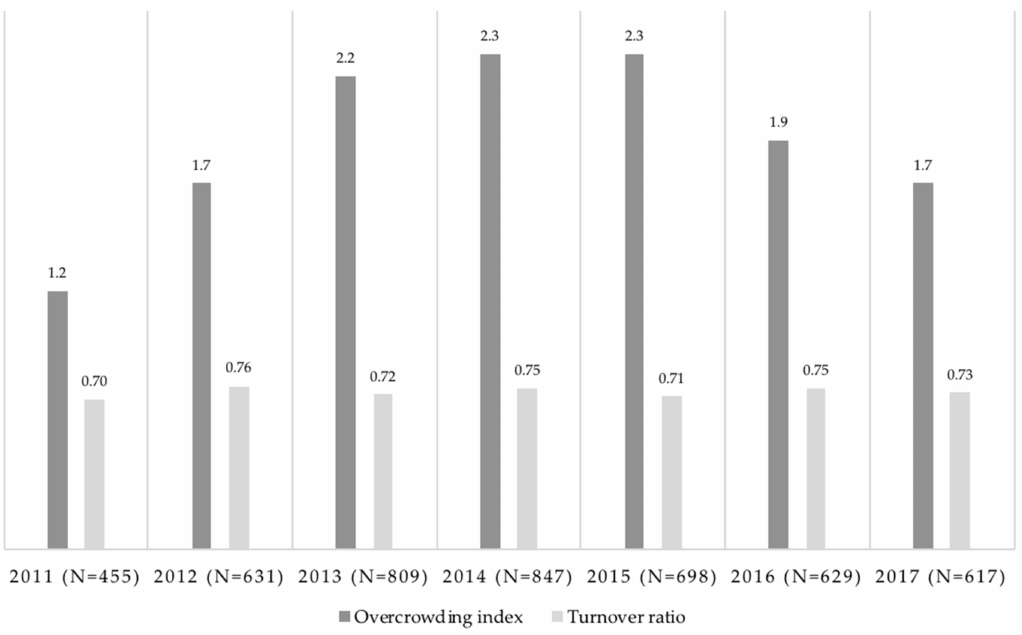
Figure 1. Descriptive statistics for overcrowding and turnover and number of PLD (people living in detention) each year.